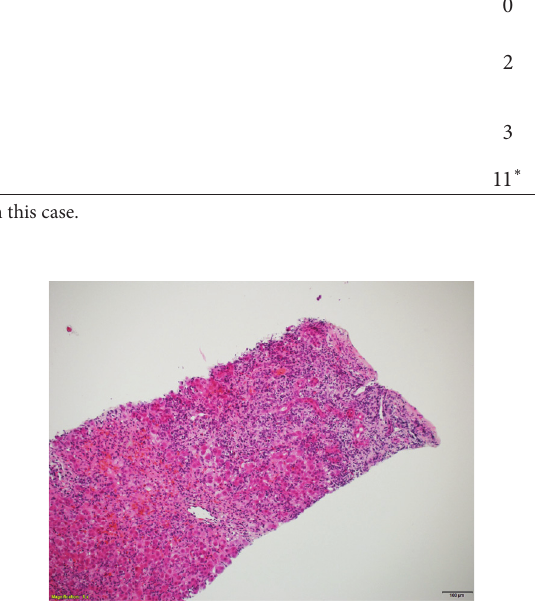
Figure 2: Liver biopsy showing severe interface hepatitis with moderate to severe mixed inflammatory